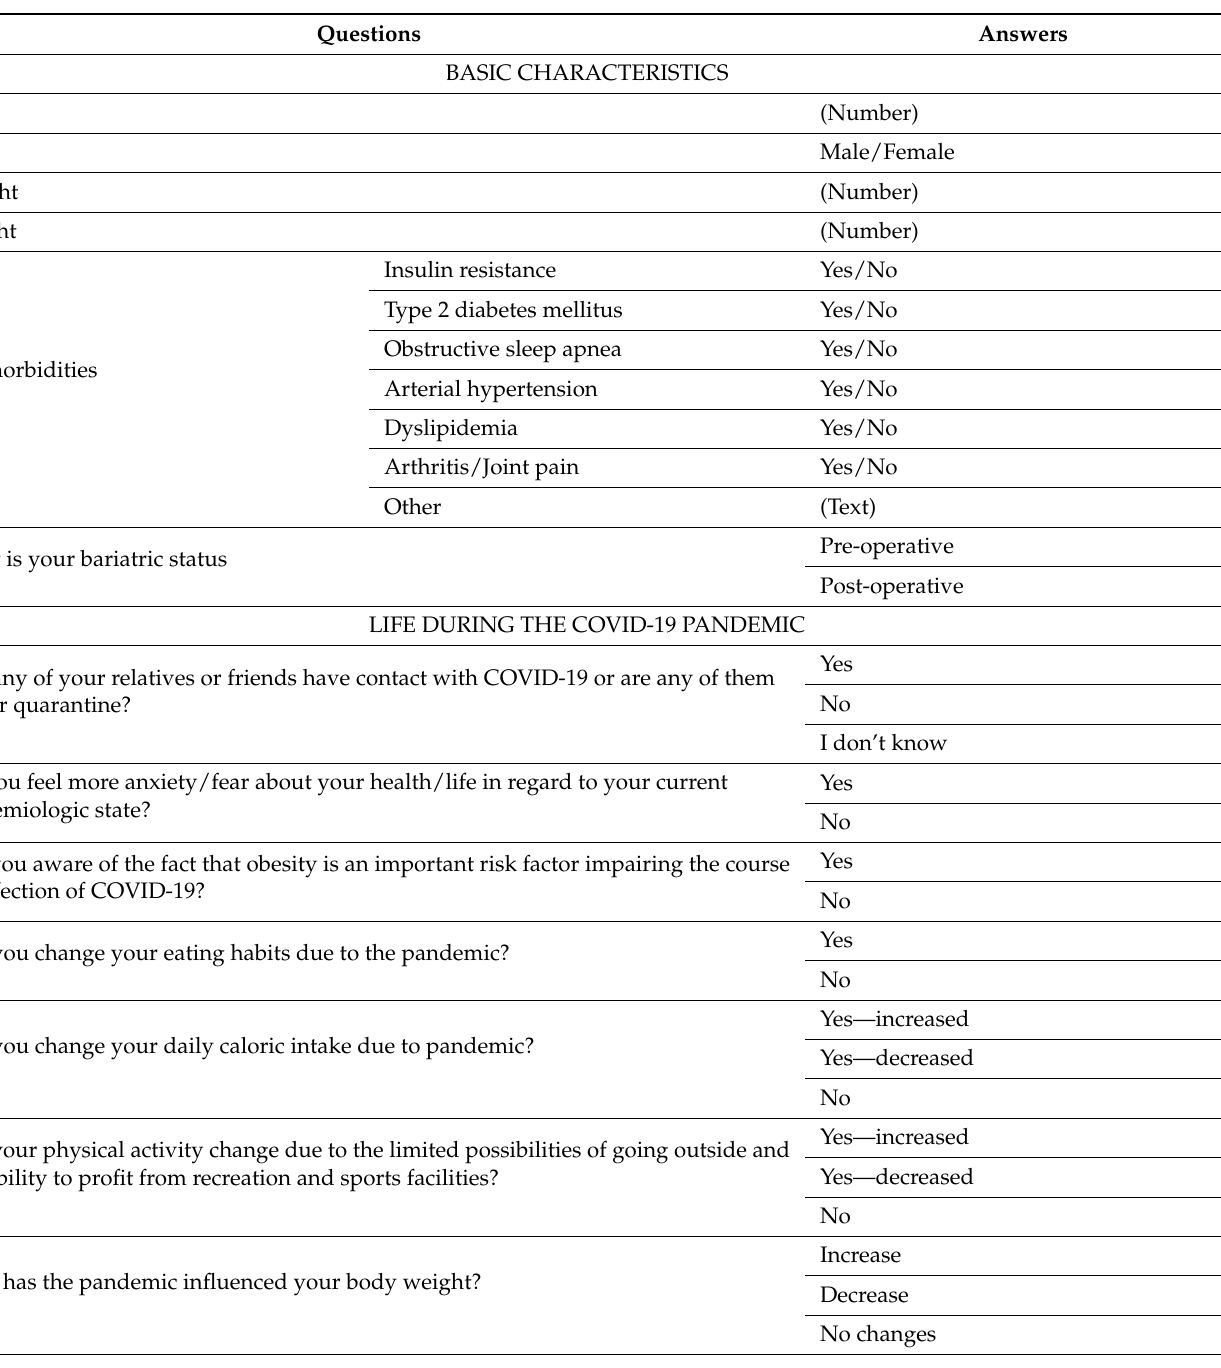
Table A1. Questionnaire for bariatric